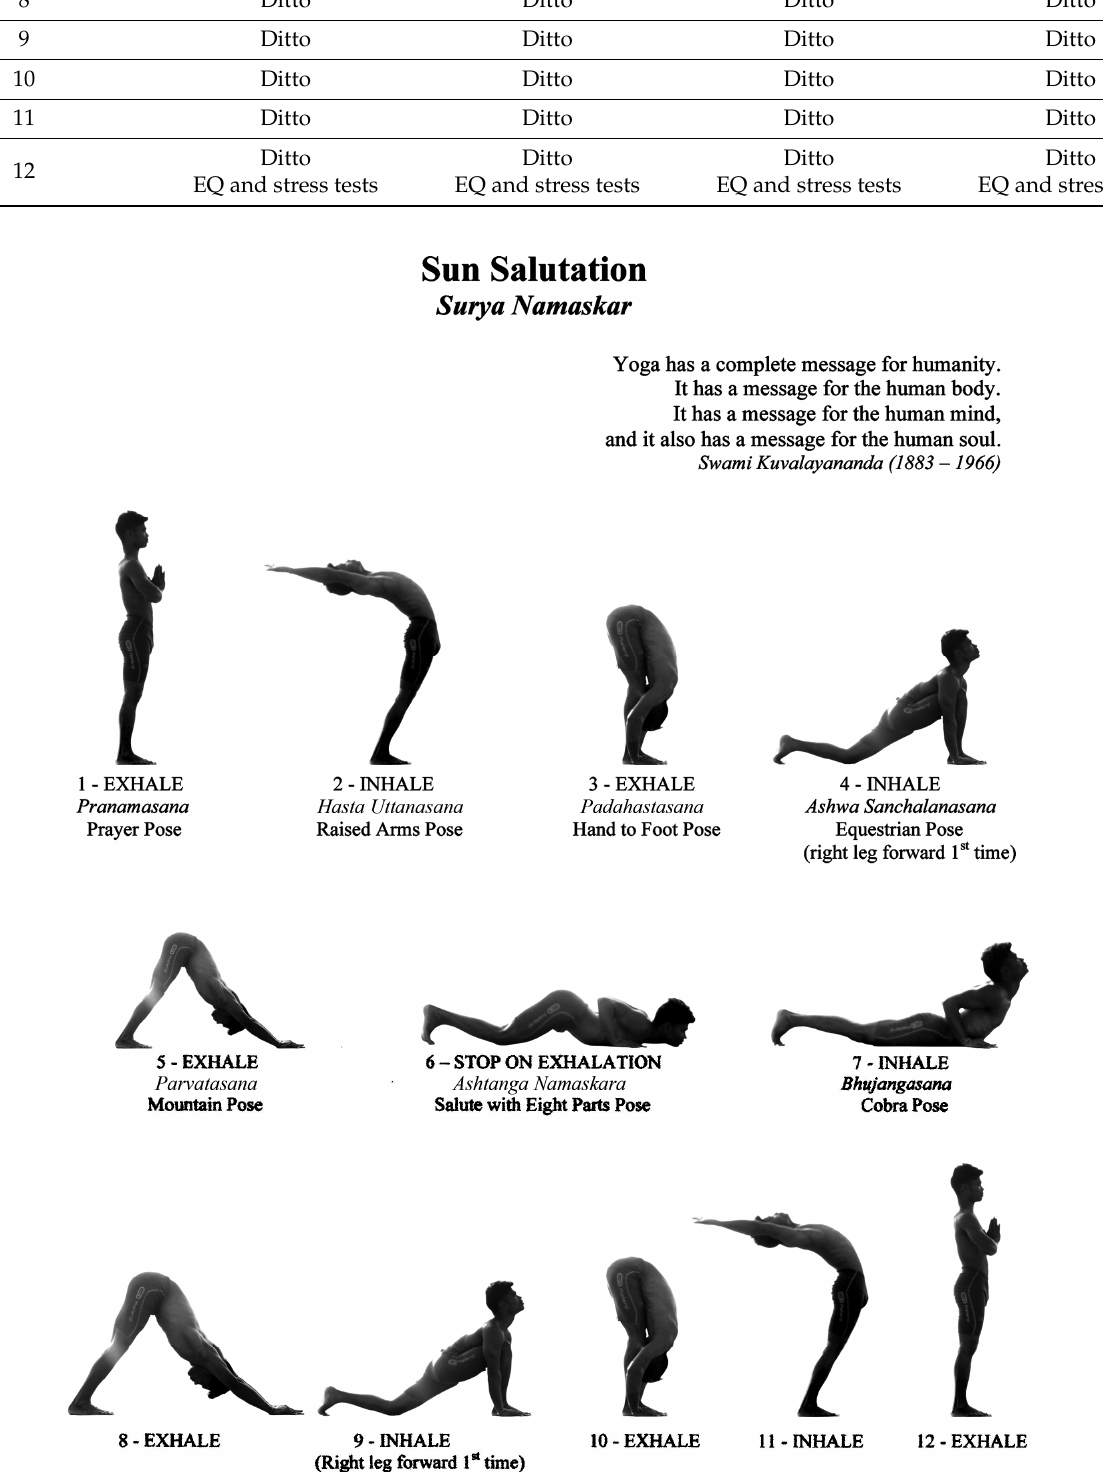
Figure A1. Sequence of asanas in the Rishikesh Series of Sun Salutations (Suryanamaskar).